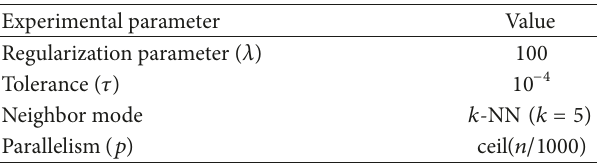
Table 2: Experimental parameters for clustering performance